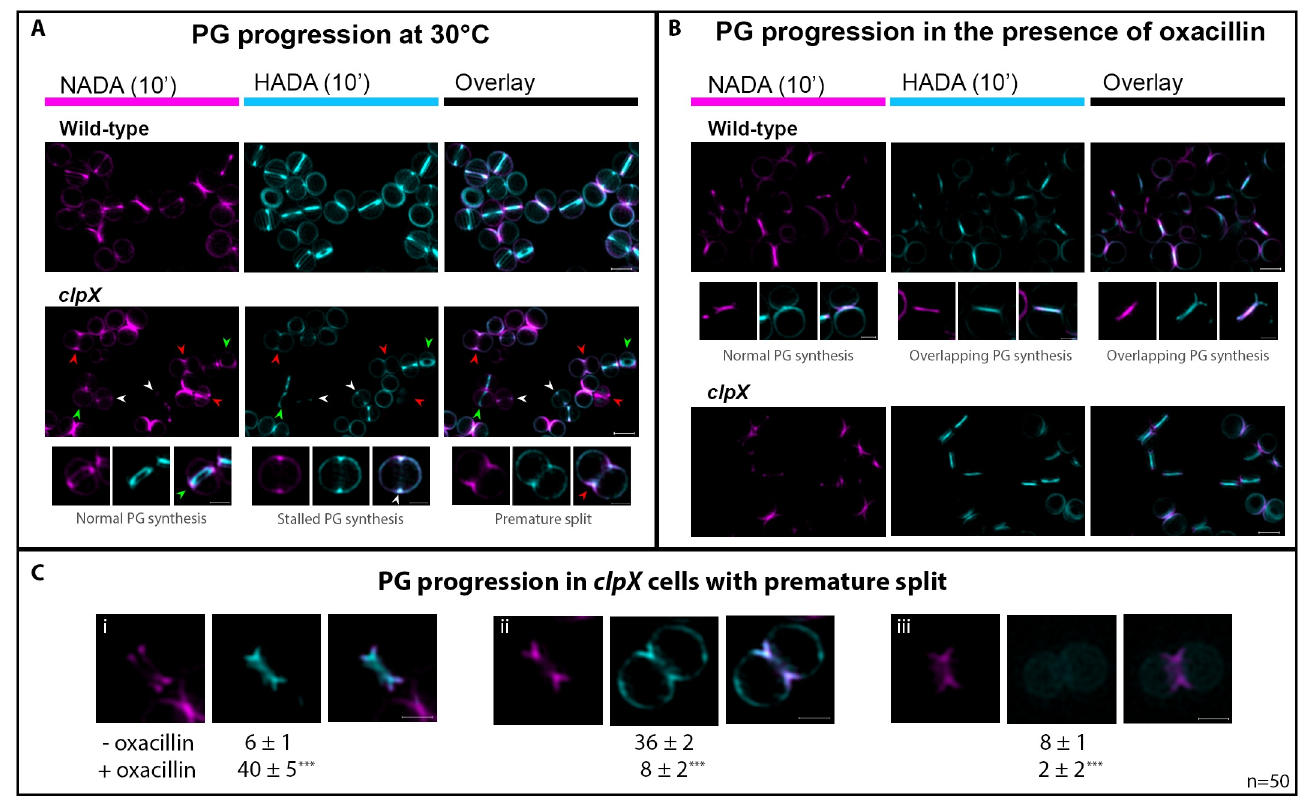
Fig 5. Aberrant progression of septal PG synthesis in S . aureus clpX cells is rescued by oxacillin. S . aureus wild-type (SA564) and clpX cells were grown at 30˚C in the absence ( A and C ) or presence of 0.05 μ g ml -1 oxacillin ( B and C ), and PG synthesis was followed by sequentially labeling with NADA for 10 min, followed by washing and labeling with HADA for additional 10 min before SR-SIM imaging. In order to improve contrast, the NADA signal is displayed in magenta, while the HADA signal is displayed in cyan. In the absence of oxacillin ( A ) septal PG synthesis progressed predictably in wild-type cells and in some clpX cells (= non- overlapping septal NADA and HADA signals, marked with green arrows). In contrast, some clpX cells that initiated septum formation during the first period of labeling showed co-localization of NADA and HADA signals in an early septum ingrowth + HADA signal in the peripheral wall (examples are marked with white arrows), and in some of these cells splitting of the premature septum was observed (examples marked with red arrows). Enlarged examples are depicted in the lower panel. ( B ) In the presence of sub-lethal concentrations of oxacillin, some wild-type cells displayed overlapping NADA and HADA septal signals (examples displayed in middle panel), a phenotype that was not observed for clpX cells grown in the presence of oxacillin. ( C ) To examine progression of septal PG synthesis in clpX cells displaying premature septal split, 50 cells from each of three biological replicates (grown +/- oxacillin) that initiated septum formation during incubation with NADA, and displayed premature splitting were randomly selected. PG synthesis was followed by assessing HADA incorporation. (i-iii) show examples and distribution of the three phenotypes observed. (i) show the number of cells where septum synthesis was continued; (ii) shows the number of cells that did not continue septum synthesis and instead displayed a HADA signal in the peripheral wall; (iii) shows the number of cells where no HADA signal was detected. Numbers are given as the mean and SD of the three biological replicates. Scale bars, 0.5 μ m. ��� P < 0.001; statistical analysis was performed using the chi square test for